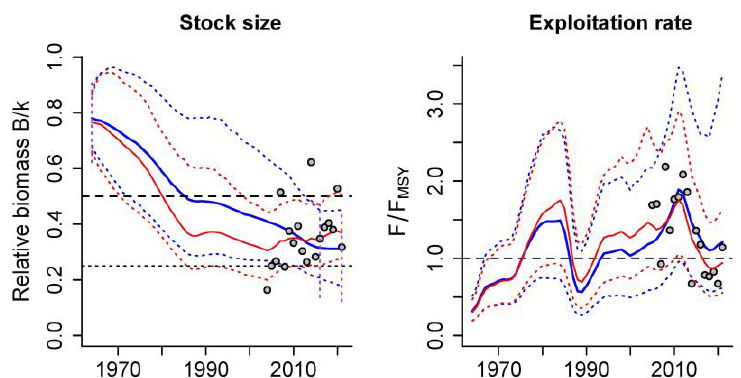
Figure 2. Relative stock size B/k (proxy for B/B MSY ) and exploitation rate (F/F MSY ) of Raja clavata in the Balearic Islands between 1964 and 2021. Blue and red lines show the predictions estimated from CMSY and the Bayesian state-space Schaefer surplus production (BSM) components of the CMSY++ method, respectively. The dots indicate the observed abundance data scaled by BSM. The horizontal dashed lines represent B MSY and F MSY and the dotted line in the stock size plot indicates 0.5B MSY.